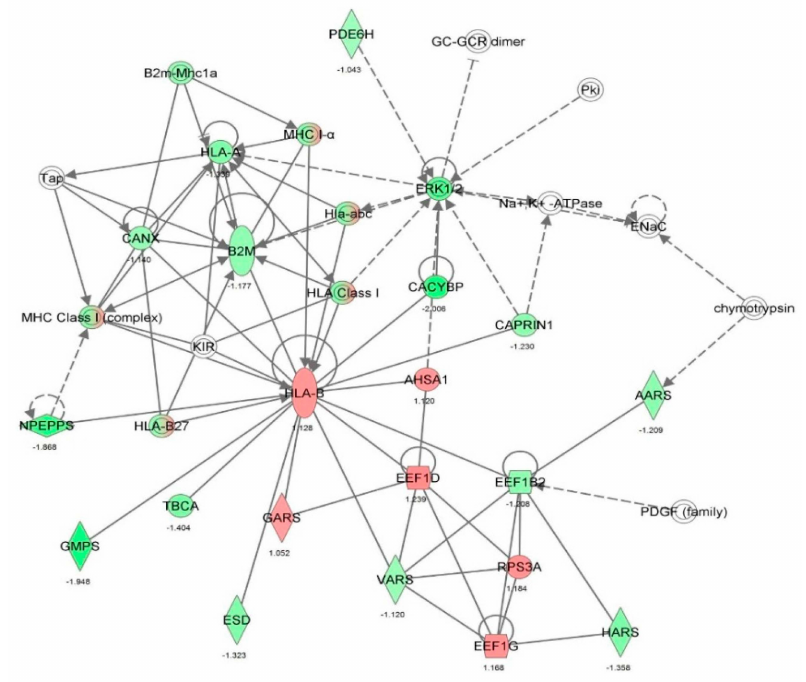
Figure 17. Vancomycin regulated post-translational modification, protein folding, and dermatological diseases and conditions. Red indicates an up-regulation; green indicates a down-regulation. The intensity of green and red colors indicates the degree of down- or up-regulation. Solid arrow indicates direct interaction and dashed arrow indicates indirect